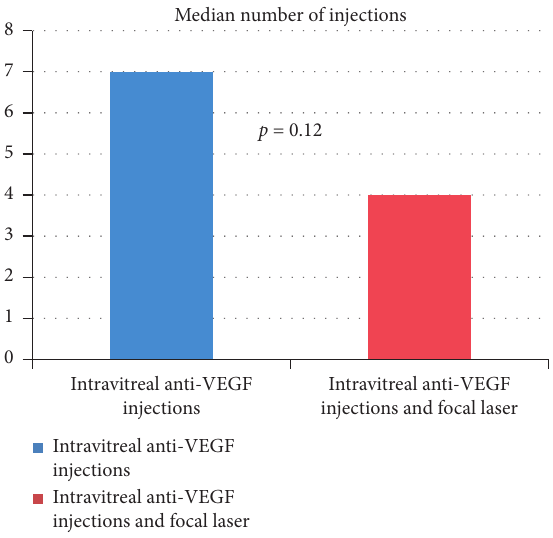
Figure 3: Number of intravitreal injections comparison between anti-VEGF injections alone and anti-VEGF injections combined with focal